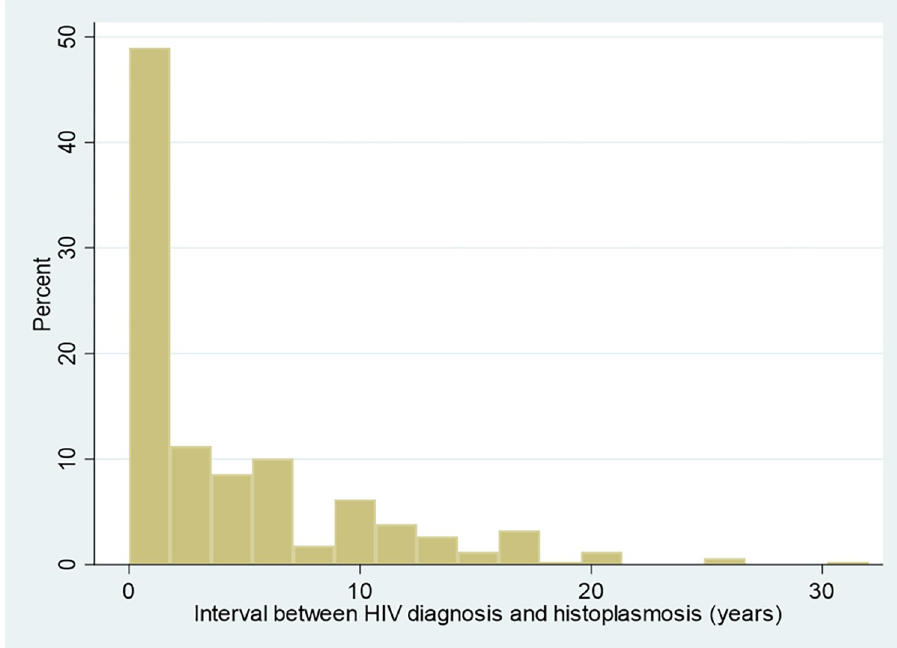
Fig 2. Interval between HIV diagnosis and progressive disseminated histoplasmosis.